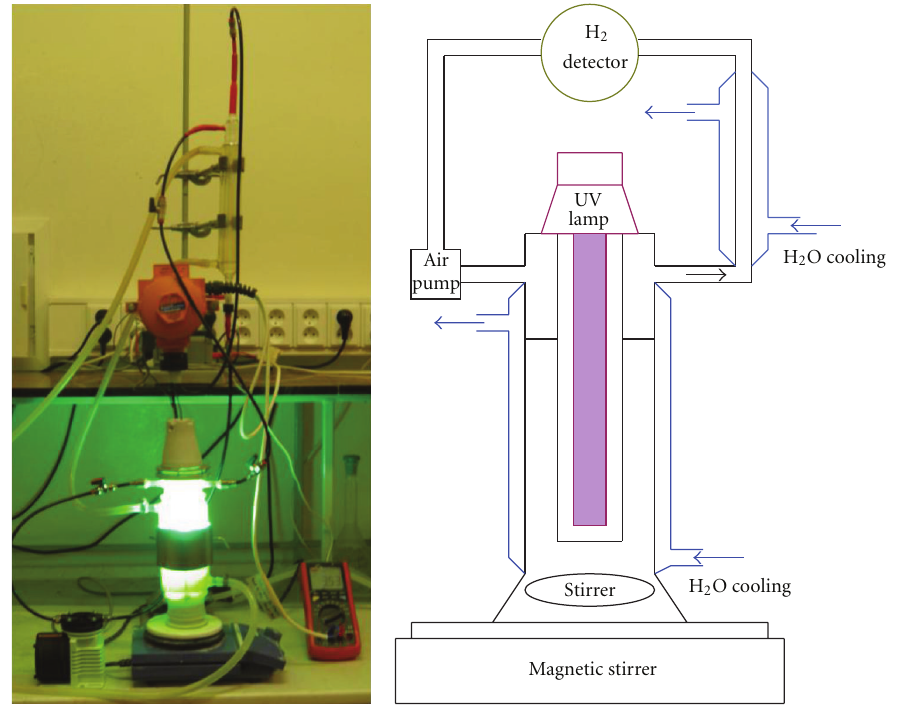
Figure 1: Batch photocatalytic reactor for H 2 evolution.